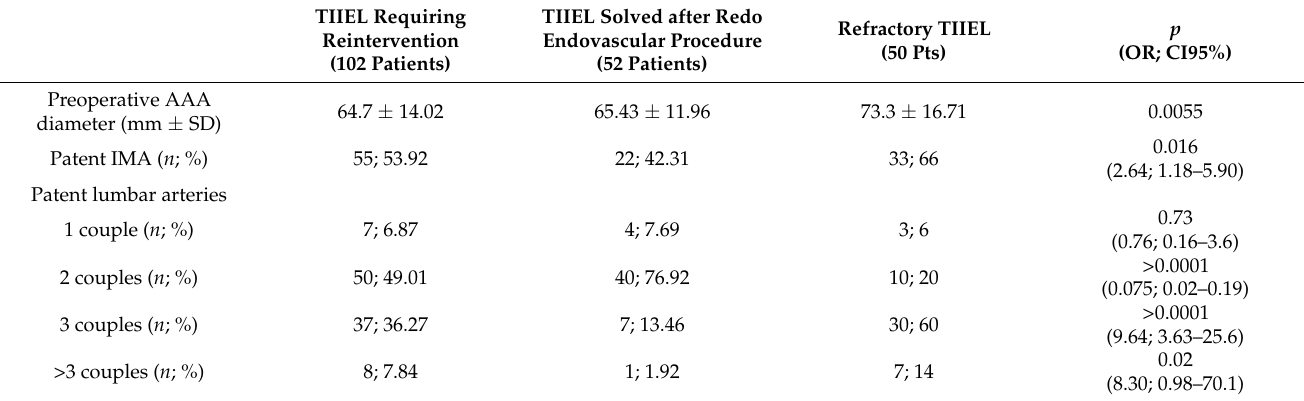
Table 2. Preoperative anatomical characteristics of patients included in present study.